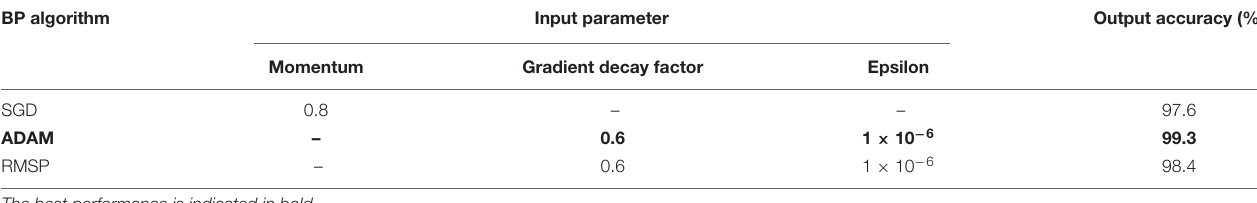
TABLE 3 | Comparison of the validation accuracy with three back propagation (BP) algorithms. BP algorithm